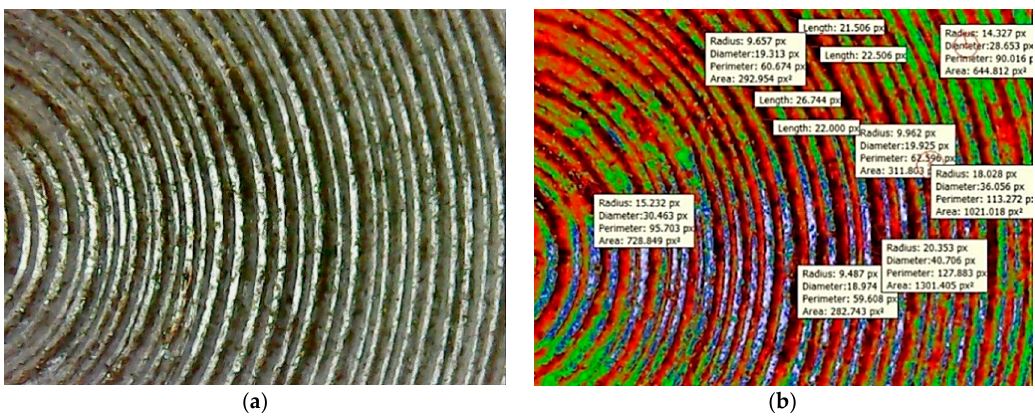
Figure 12. ( a ) Friction welded tracks at the welded interface. ( b ) Segment based analysis image.